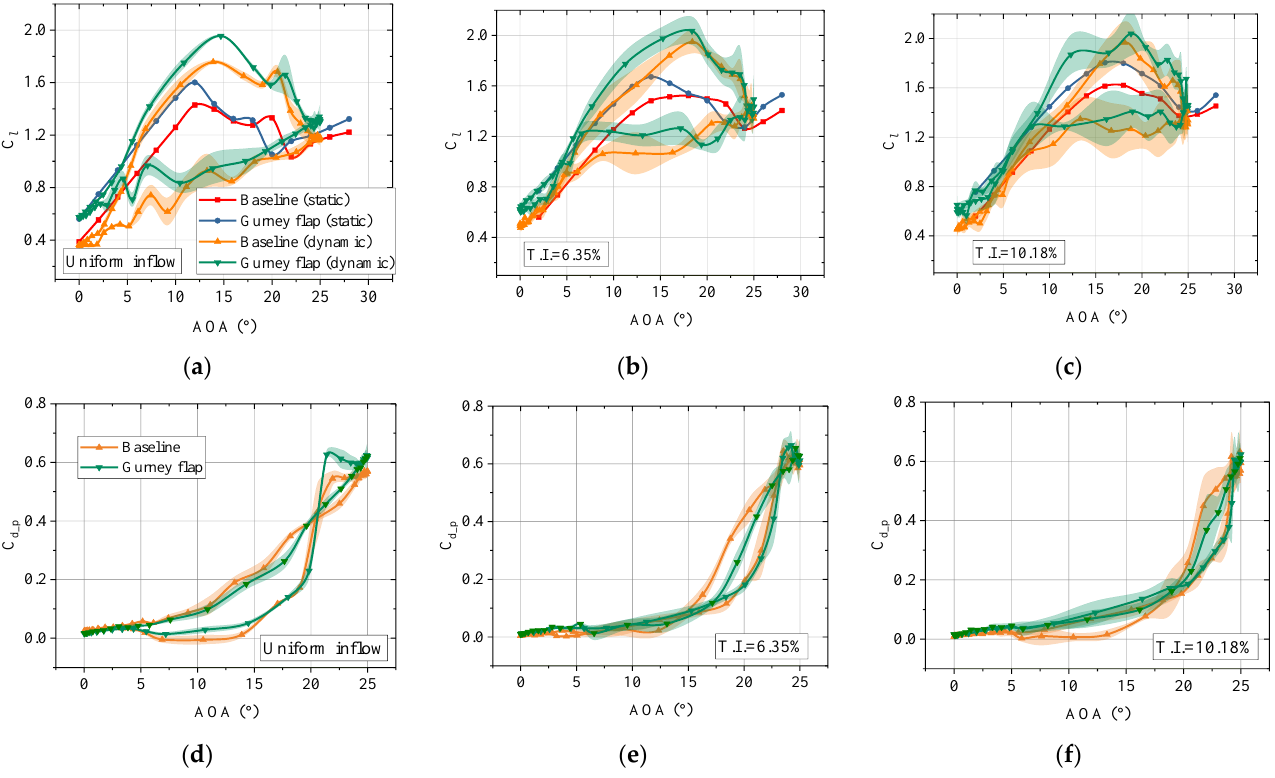
Figure 9. Comparison of lift and pressure drag coefficients A = 12.5, α mean = 12.5 and K = 0.0167. ( a ) lift coefficients, uniform inflow; ( b ) lift coefficients, T.I. of 6.35%; ( c ) lift coefficients, T.I. of 10.18%; ( d ) pressure drag coefficients, uniform inflow; ( e ) pressure drag coefficients, T.I. of 6.35%; ( f ) pressure drag coefficients, T.I. of 10.18%.